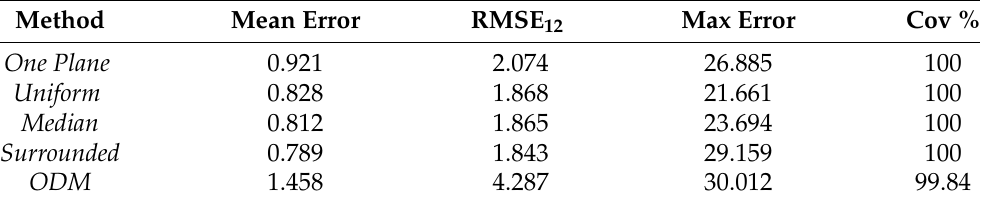
Table 8. Comparison, using METRO , between the different partitioning methods and the original mesh. The Surrounded method shows the better performance in all the metrics, and shows a bigger improvement in comparison with the default method used by